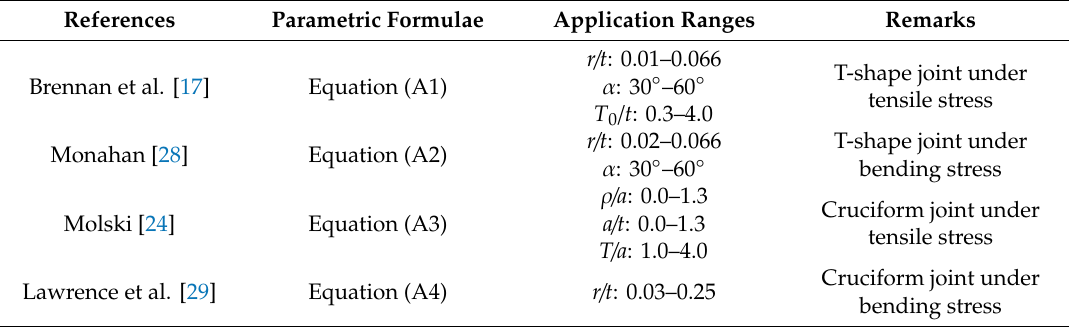
Table 1. Typical parametric formulae for SCF of the T-shape joints and cruciform